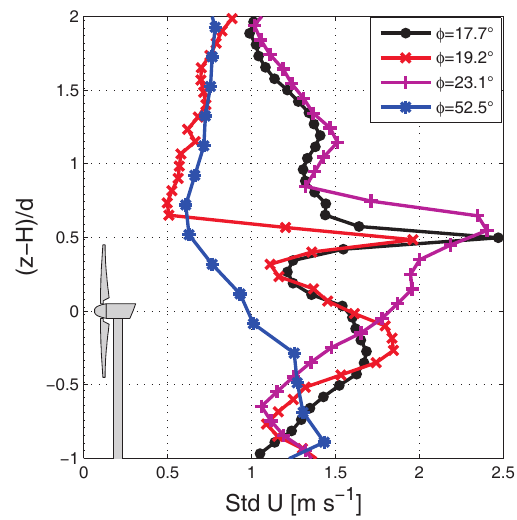
Figure 5. Velocity standard deviation obtained by staring a LiDAR with di ff erent elevation angles.